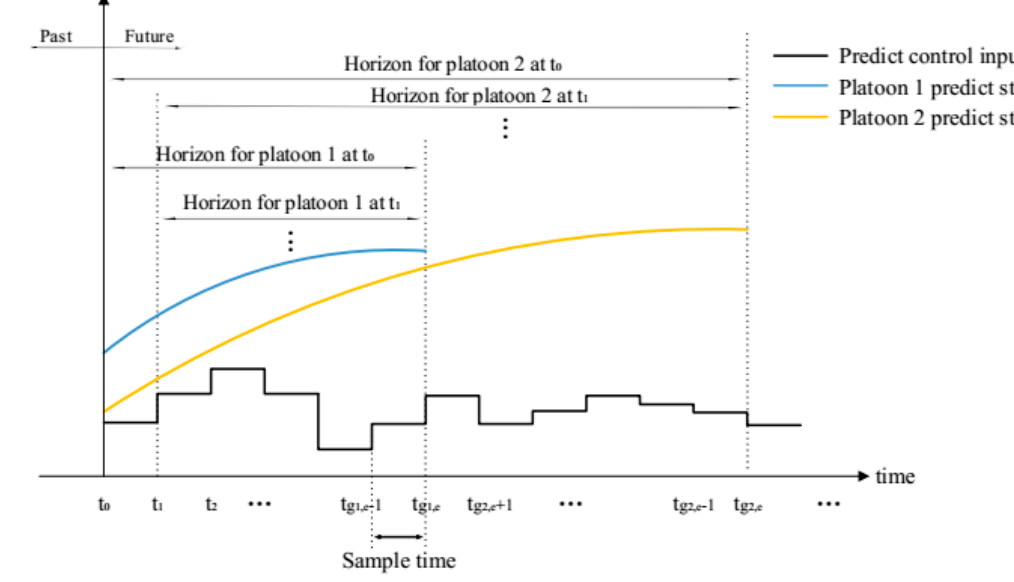
Figure 1. Model predictive control for connected and autonomous vehicle (CAV) platoons.